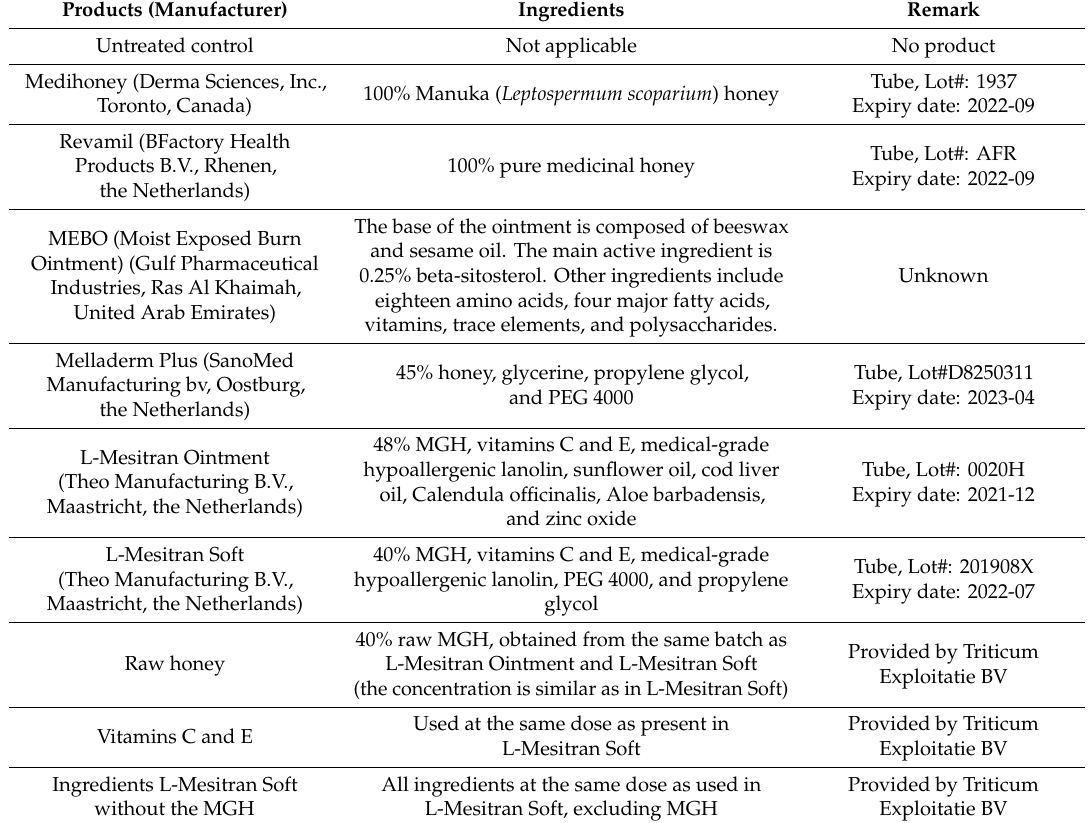
Table 1. Wound care products used in this